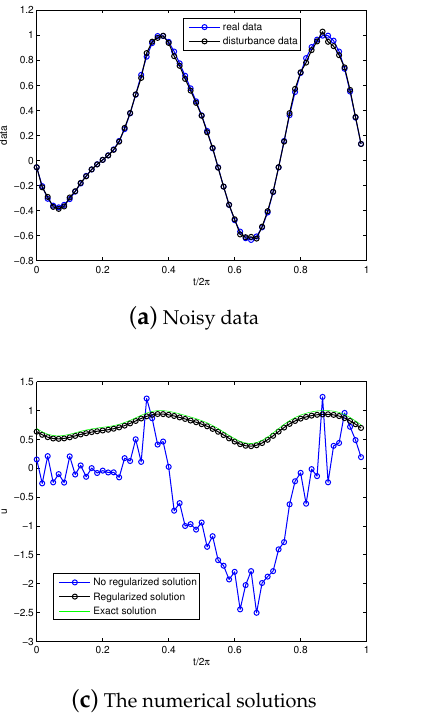
Figure 7. The numerical solutions for Example 5: ( a ) noisy data, ( b ) the errors for | f − f δ | , ( c ) the numerical